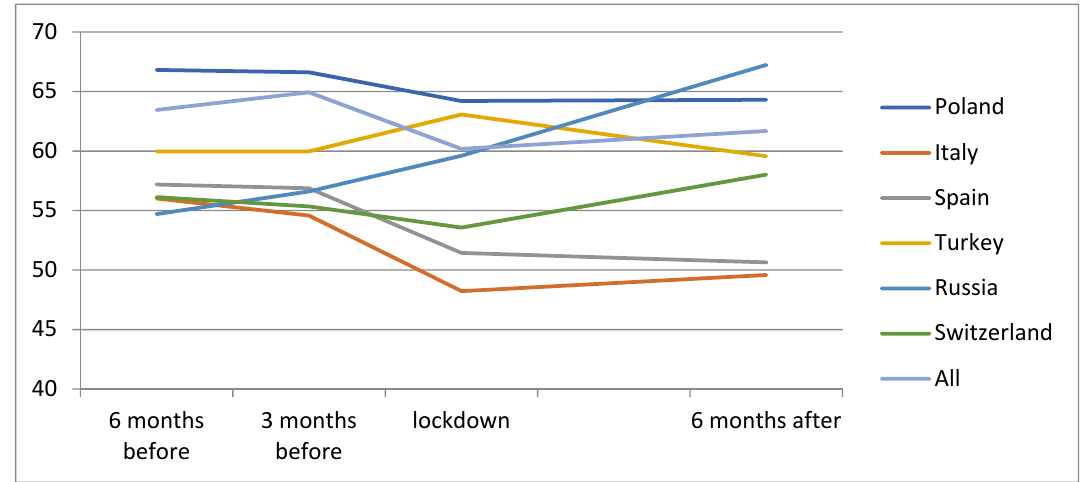
Figure 1. Mean evolution of the BCVA per country.